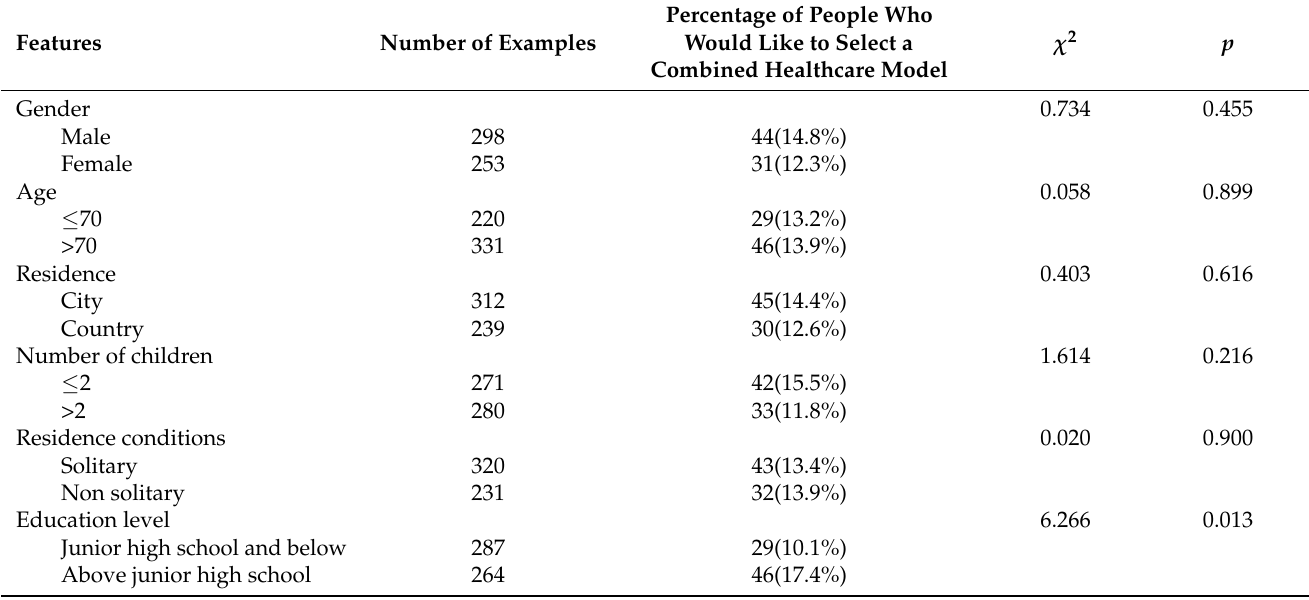
Table 1. Analysis of the willingness of the elderly to select the combined medical care and nursing care model with different